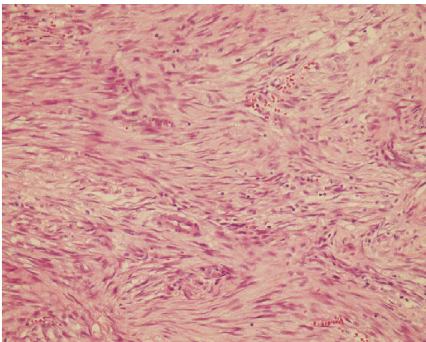
Figure 1: Picture shows that spindle cell proliferation admixed with inflammatory cells (HE × 40).